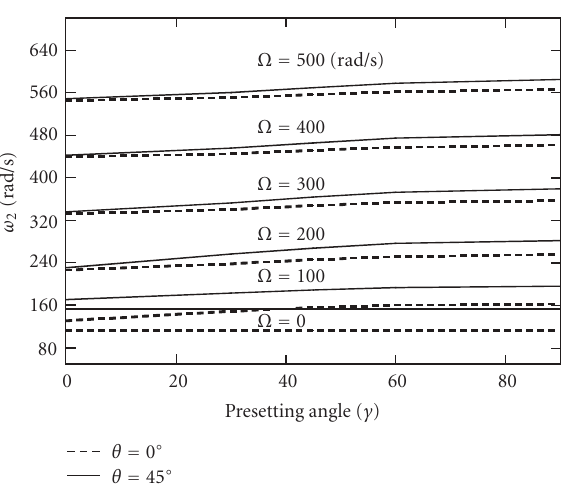
Figure 9: Variation of the third coupled frequency versus pretwist- ed angle for selected rotational speeds and two di ff erent taper ratios ( θ = 90 deg).